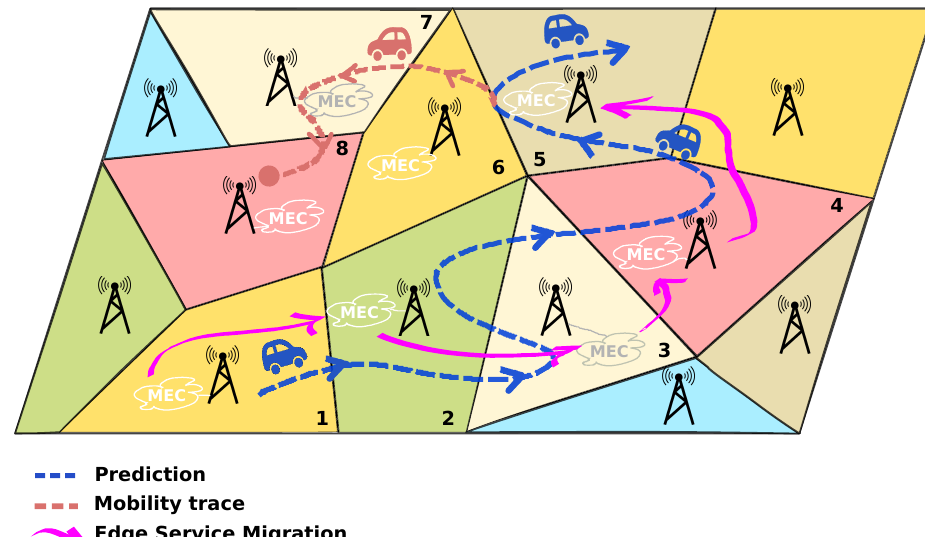
Figure 2. Example service migration due to change in coverage